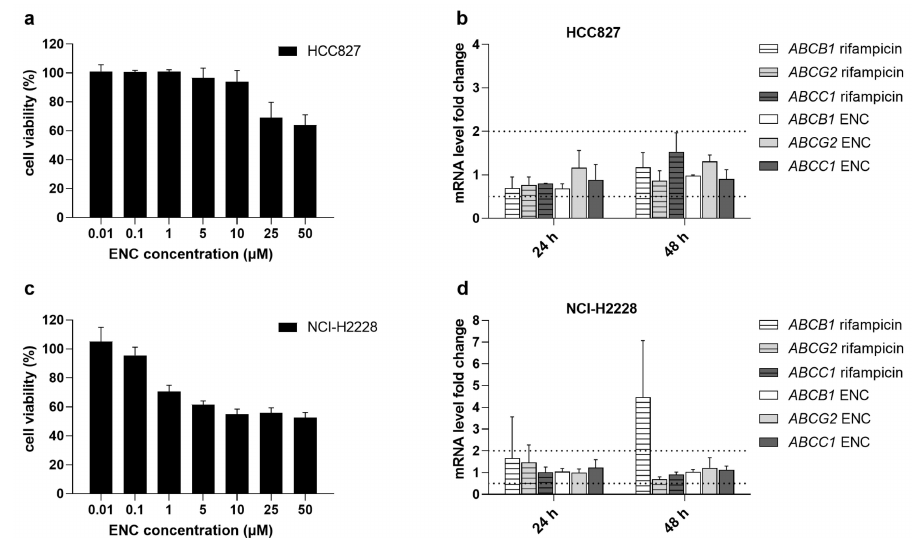
Figure 6. Effects of encorafenib on the mRNA levels of ABCB1 , ABCG2, and ABCC1 in NSCLC cell lines. Cell viabilities were determined by MTT assay in ( a ) HCC827 and ( c ) NCI-H2228 cells after exposure to encorafenib for 48 h. A total of 1 µ M encorafenib or 25 µ M rifampicin was added to the tested cells for 1 or 2 days with the daily replacement of drug dilutions. The mRNA expression levels of ABC transporters and house-keeping genes were evaluated by qRT-PCR. After data analysis, fold changes in mRNA levels of examined genes in ( b ) HCC827 and ( d ) NCI-H2228 were presented. According to the drug–drug interaction research guideline released by the European Medicines Agency [25], limits for upregulation or downregulation were defined by the presented dotted lines. At least 3 independent experiments were performed. ENC, encorafenib; error bar, standard deviation.